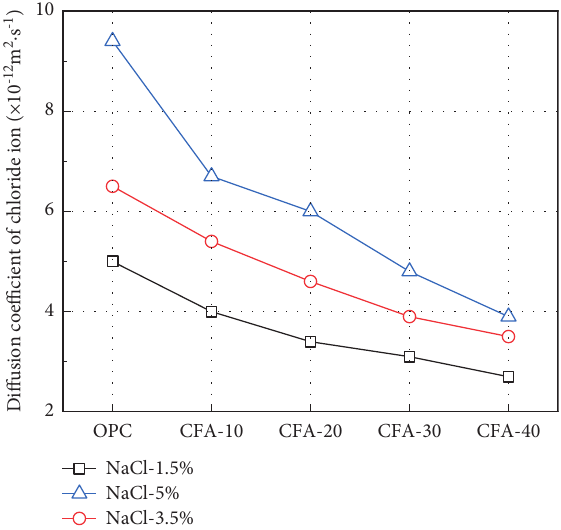
Figure 7: Diffusion coefficients of chloride ions.